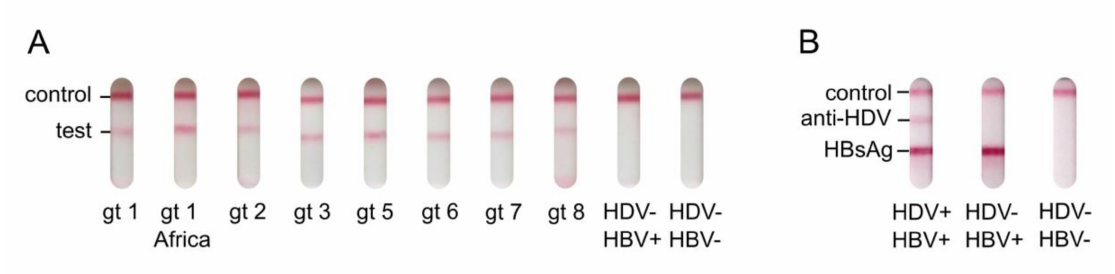
Figure 4. Pan-genotypic activity of the HDV rapid test and HBsAg multiplexing. ( A ) Pan-genotypic activity of the HDV rapid test. Anti-HDV-positive samples of patients that were infected with specific HDV genotypes were run on the HDV rapid test. Anti-HDV-negative samples of HBsAg-positive and -negative patients were used as controls. ( B ) Multiplexing of the HDV rapid test with the detection of HBsAg. Anti-HBsAg was spotted as a third line on the HDV rapid test for the detection of HBsAg in patient serum or plasma. The conjugate pad was treated with a mixture of gold-conjugated goat anti-human IgG and gold-conjugated mouse anti-HBsAg. The result of a single proof-of-principle experiment is